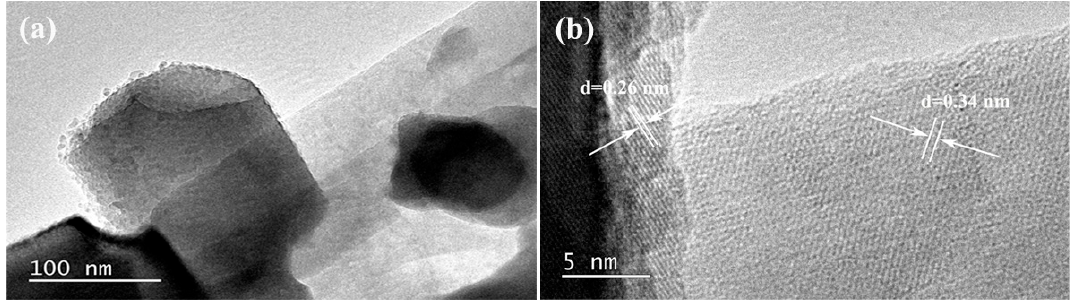
Figure 2. ( a ) TEM image of ZRP heterostructure; ( b ) HRTEM image of ZRP heterostructure.